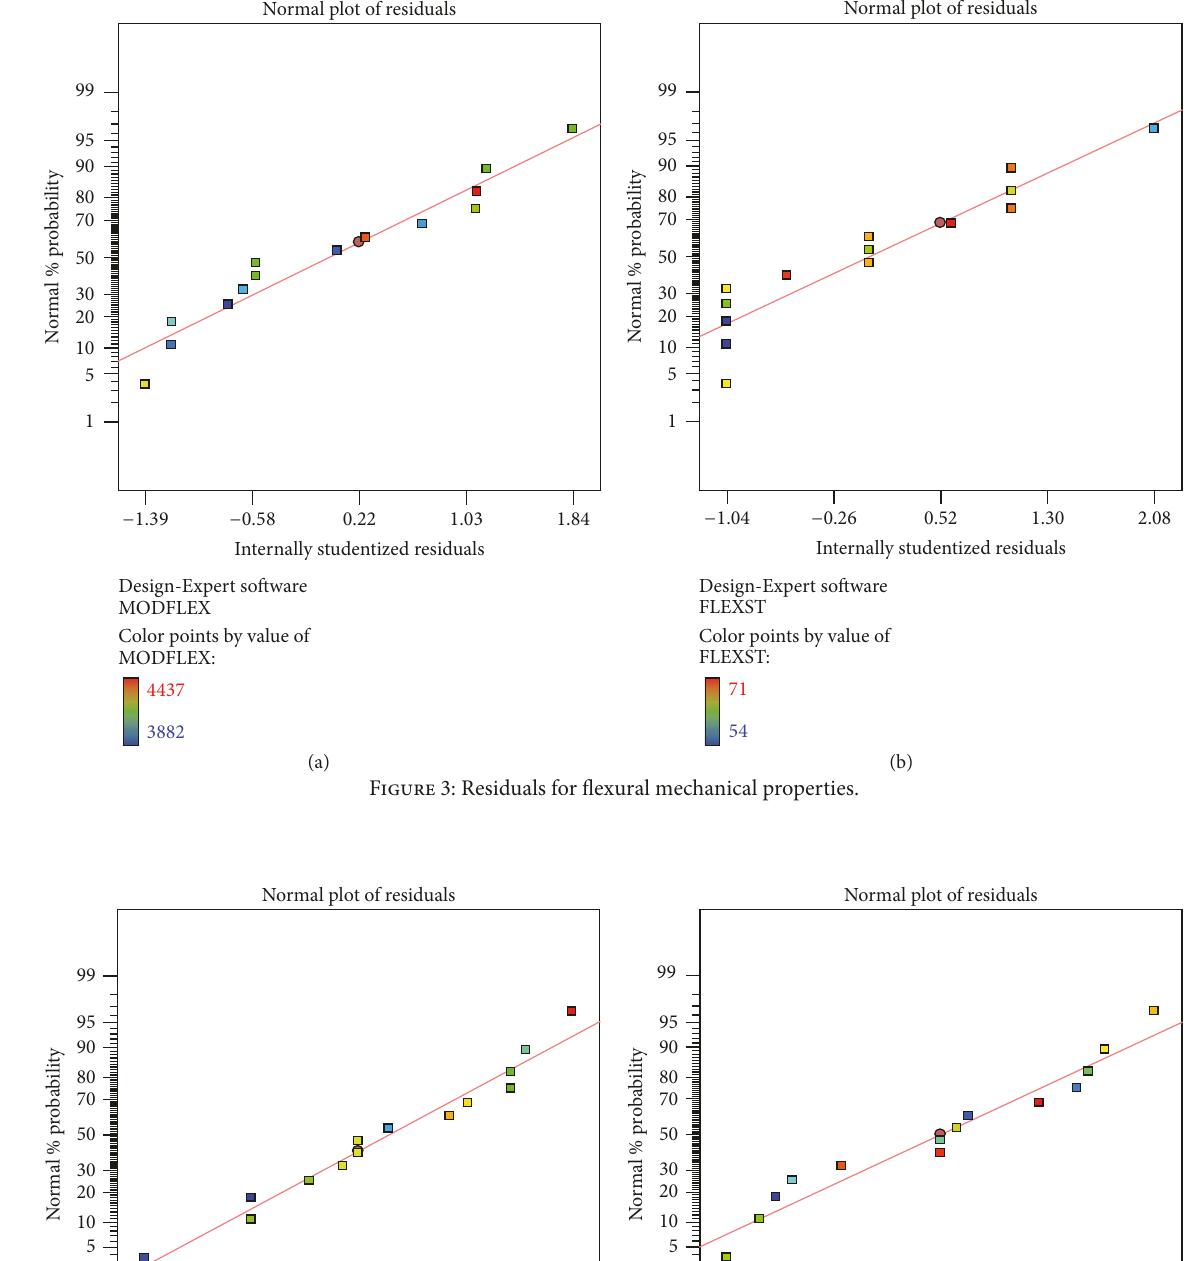
Figure 4: Residuals for (a) HDT and (b) Charpy impact